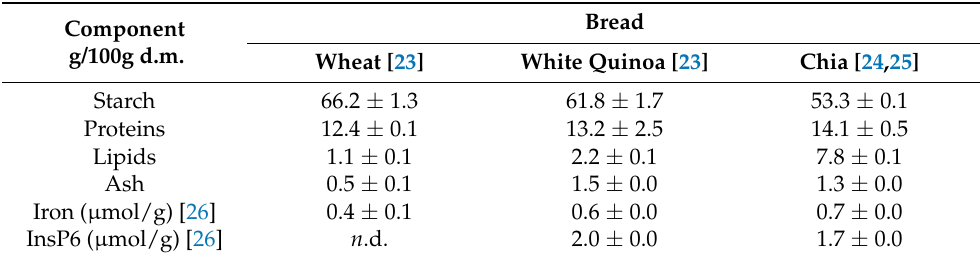
Table 1. Proximal composition of C. quinoa - and S. hispanica L-containing bread formulations admin- istered in the study. Component g/100g